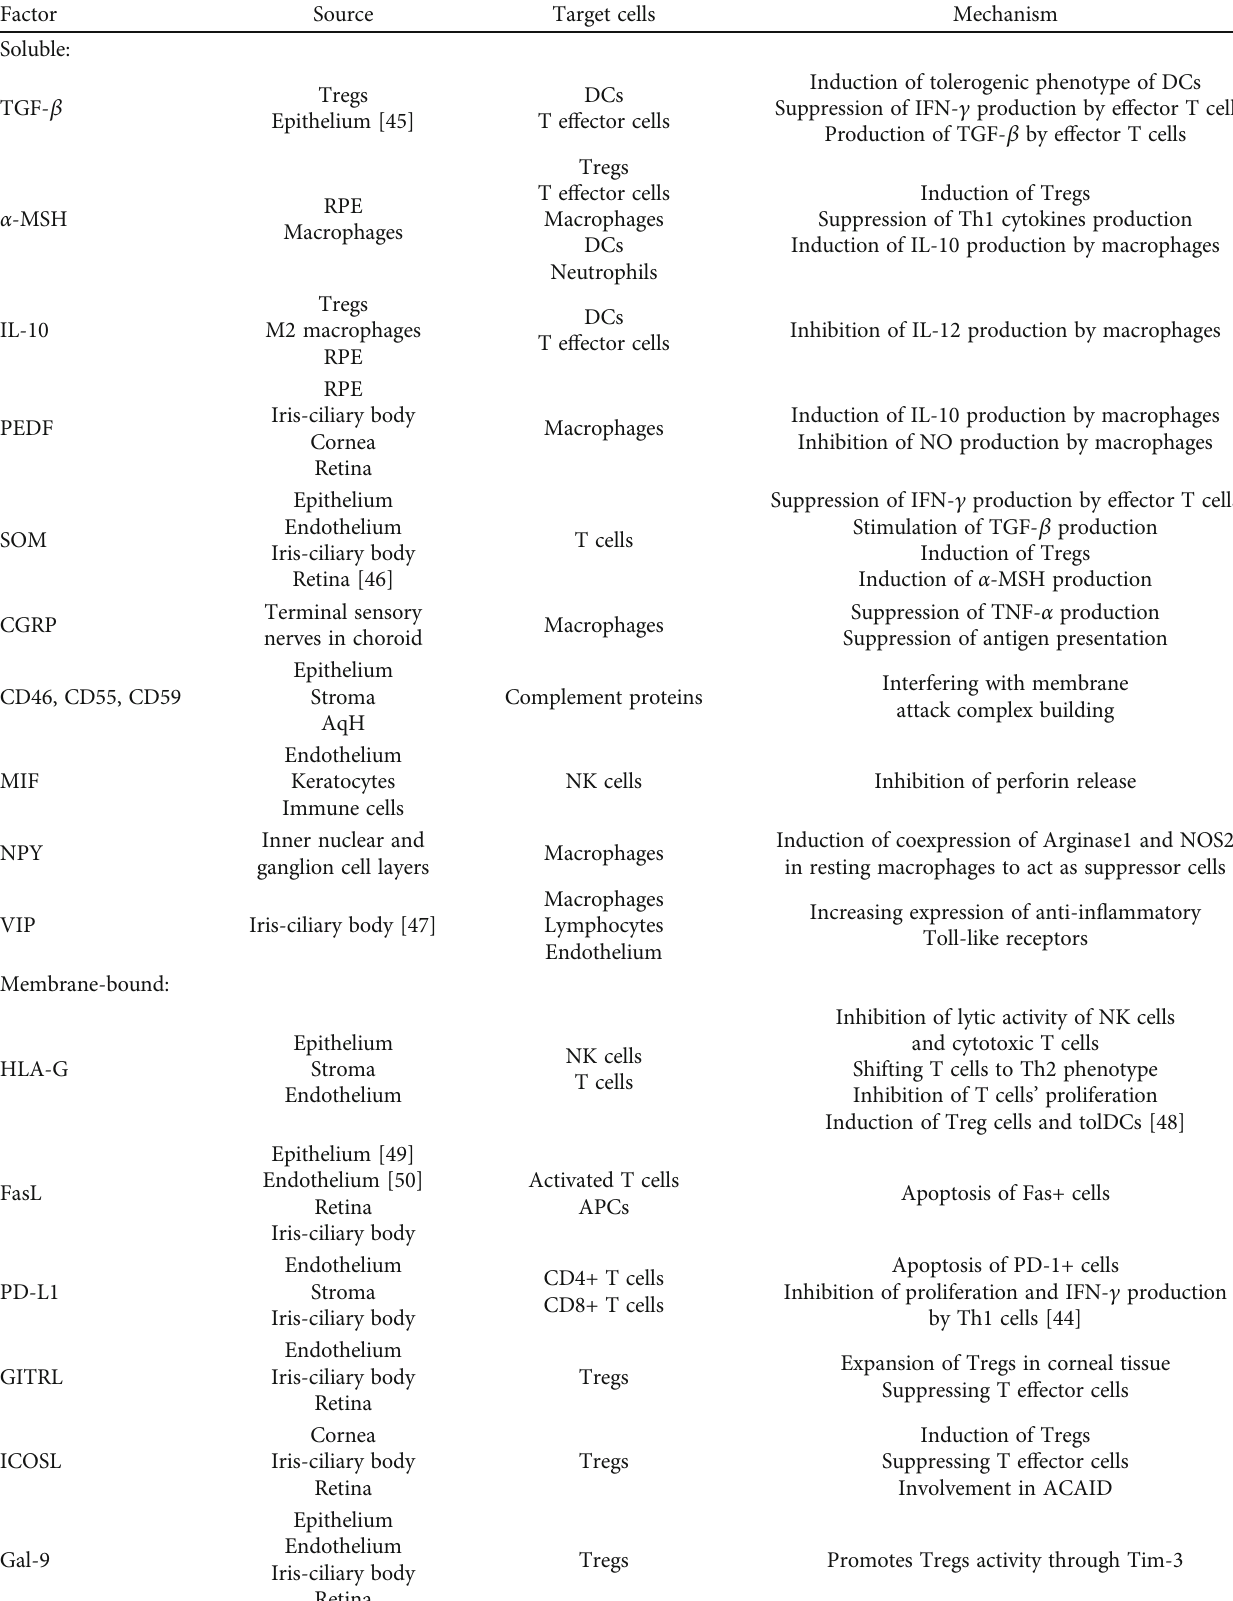
Table 1: Soluble and cell surface factors providing immune privilege of the